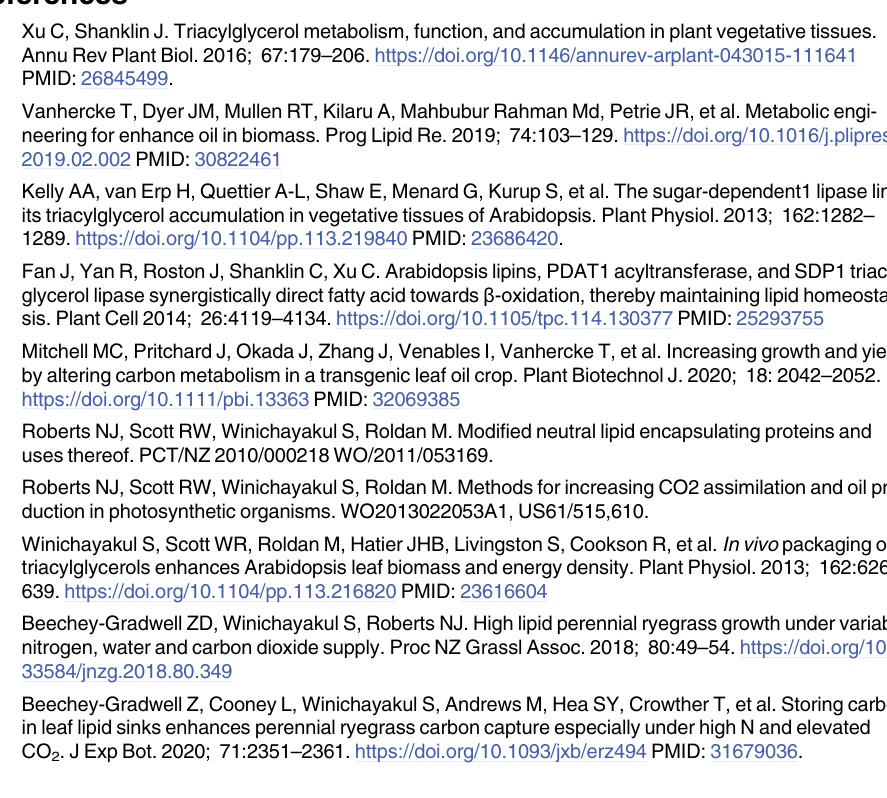
point intervals (S1A Fig) and divided into 5 organs (S1B Fig): Leaf tip, leaf middle, ligule, sheath and root (cleaned). Plant materials were freeze-dried for 3–4 d and stored at -80 ˚C until use for sugars and FA analysis (S1C and S1D